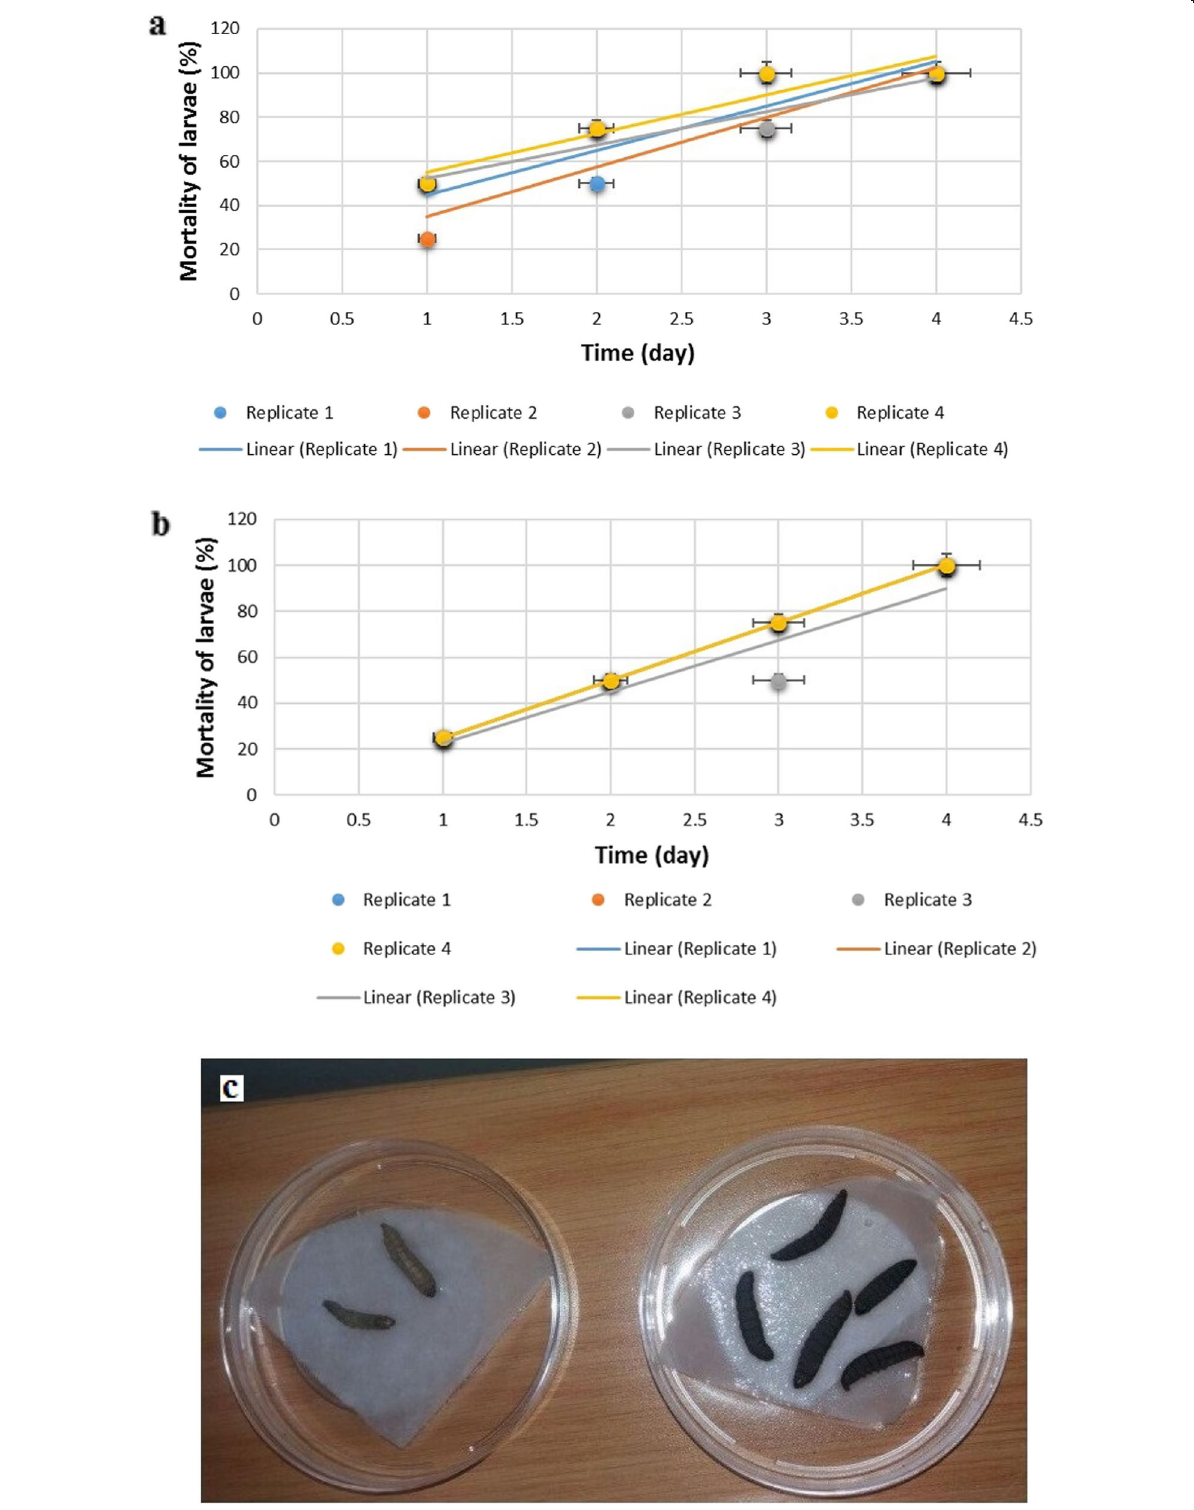
Fig. 2 Infectivity of Heterorhabditis zealandica strain ETL against both a Galleria mellonella and b Tenebrio mollitor larvae. c White-trap used to collect infective juveniles from larva cadavers, a Petri dish with distilled water, and G. mellonella larva on filter paper. Live G. mellonella larvae (left) versus dead G. mellonella larvae